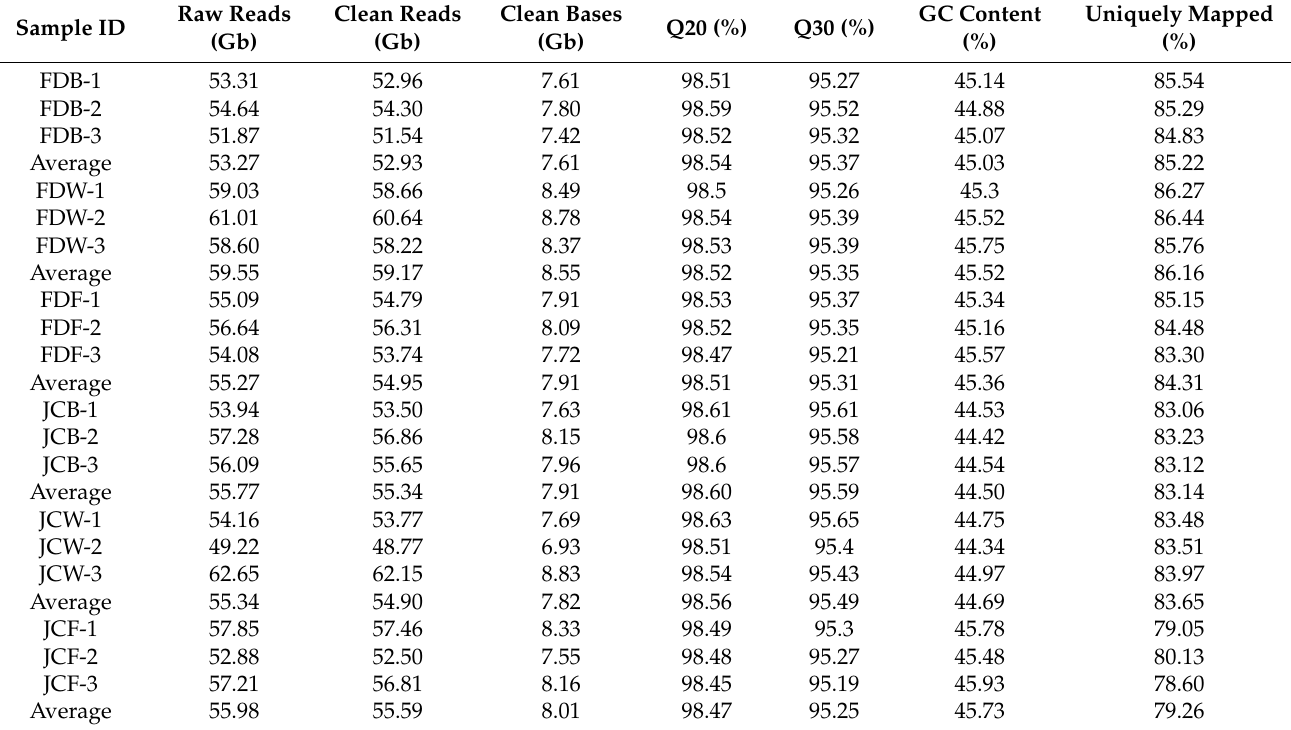
Table 1. Data assembly for transcriptome